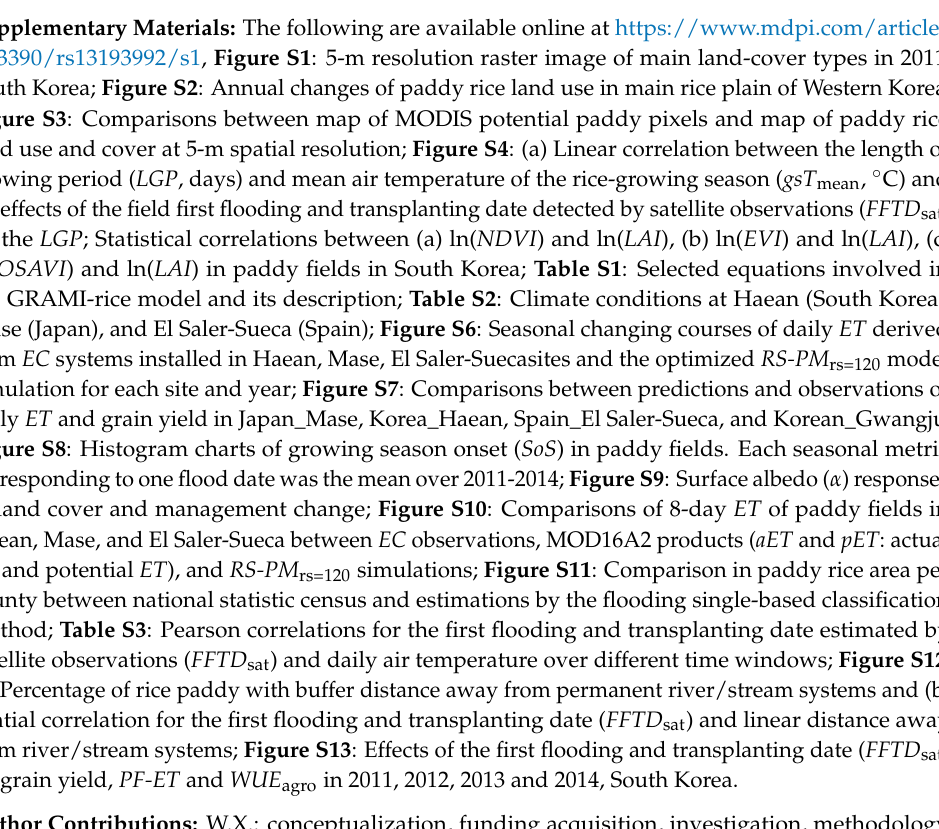
Figure S3 : Comparisons between map of MODIS potential paddy pixels and map of paddy rice land use and cover at 5-m spatial resolution; Figure S4 : (a) Linear correlation between the length of growing period ( LGP , days) and mean air temperature of the rice-growing season ( gsT mean , ◦ C) and (b) effects of the field first flooding and transplanting date detected by satellite observations ( FFTD sat ) on the LGP ; Statistical correlations between (a) ln( NDVI ) and ln( LAI ), (b) ln( EVI ) and ln( LAI ), (c) ln( OSAVI ) and ln( LAI ) in paddy fields in South Korea; Table S1 : Selected equations involved in the GRAMI-rice model and its description; Table S2 : Climate conditions at Haean (South Korea), Mase (Japan), and El Saler-Sueca (Spain); Figure S6 : Seasonal changing courses of daily ET derived from EC systems installed in Haean, Mase, El Saler-Suecasites and the optimized RS-PM rs=120 model simulation for each site and year; Figure S7 : Comparisons between predictions and observations of daily ET and grain yield in Japan_Mase, Korea_Haean, Spain_El Saler-Sueca, and Korean_Gwangju; Figure S8 : Histogram charts of growing season onset ( SoS ) in paddy fields. Each seasonal metric corresponding to one flood date was the mean over 2011-2014; Figure S9 : Surface albedo ( α ) responses to land cover and management change; Figure S10 : Comparisons of 8-day ET of paddy fields in Haean, Mase, and El Saler-Sueca between EC observations, MOD16A2 products ( aET and pET : actual ET and potential ET ), and RS-PM rs=120 simulations; Figure S11 : Comparison in paddy rice area per county between national statistic census and estimations by the flooding single-based classification method; Table S3 : Pearson correlations for the first flooding and transplanting date estimated by satellite observations ( FFTD sat ) and daily air temperature over different time windows; Figure S12 : (a) Percentage of rice paddy with buffer distance away from permanent river/stream systems and (b) spatial correlation for the first flooding and transplanting date ( FFTD sat ) and linear distance away from river/stream systems; Figure S13 : Effects of the first flooding and transplanting date ( FFTD sat ) on grain yield, PF-ET and WUE agro in 2011, 2012, 2013 and 2014, South